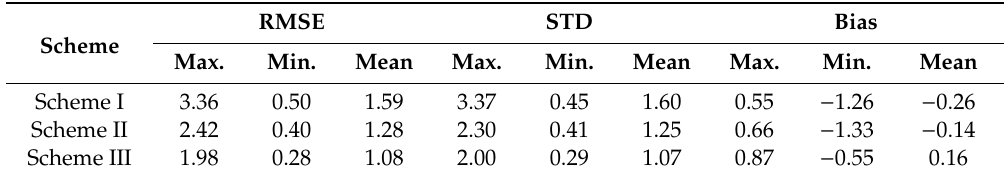
Table 6. Statistics (RMSE, STD, and bias) of the tomography results for the three schemes (unit: g / m 3 ).